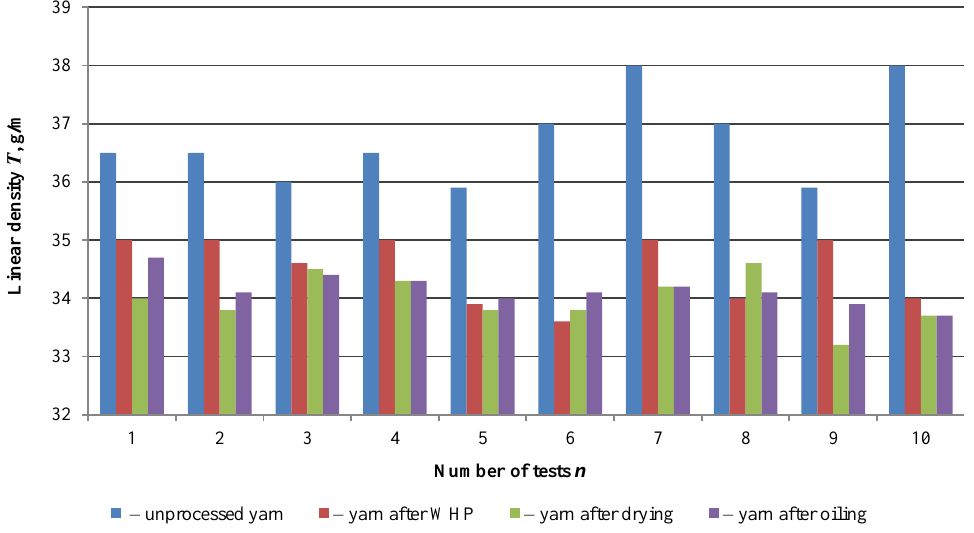
Fig. 7. The effect of mixed WTO yarn on the surface density of the weave curly